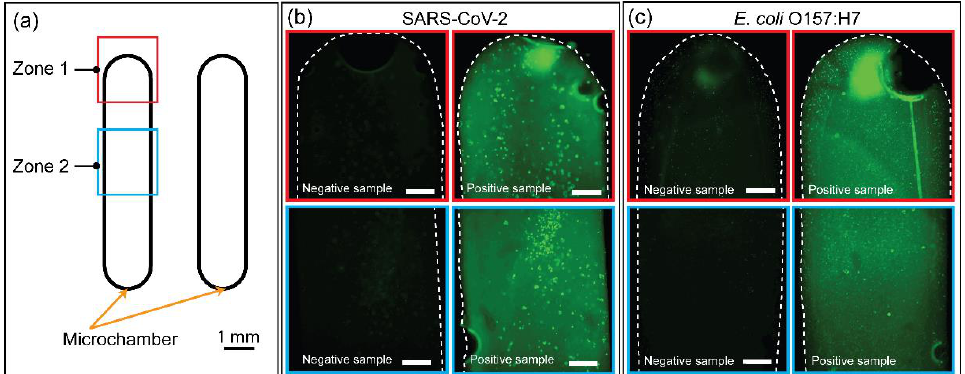
Figure 7. On-site detection of amplicons using the wearable RPA device. ( a ) Schematic illustration of the microdevice indicating two zones where the fluorescence images were captured. ( b ) Fluorescence signals of amplicons from DNA plasmid SARS-CoV-2 inside the PDMS microdevice. ( c ) Fluorescence signals of amplicons from E. coli O157:H7 inside the PDMS microdevice. Scale bars in ( b ) and ( c ) represent 200 μm.